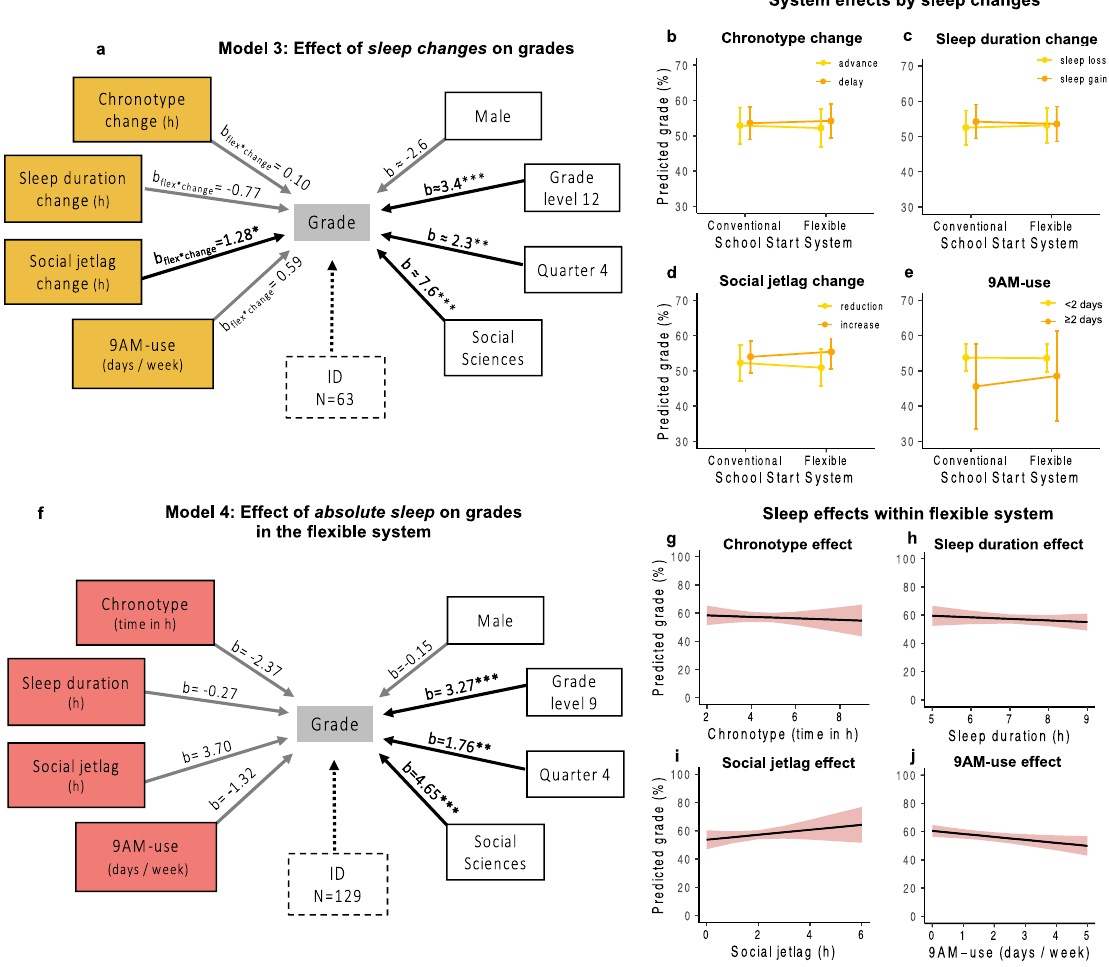
Figure 3. Longitudinal analysis of official quarterly grades—effects of sleep and 9 AM-use. Results from linear mixed model analyses of quarterly grades (0–100%) considering sleep variables and the frequency of ≥ 9 AM-starts (see Table 2 for sample descriptions). ( a,f) Schematic of the structure and results from Models 3 and 4 (Supplementary Tables S3 and S4) showing the outcome, official quarterly grades (center), all predictors (black-framed boxes), the statistical significance of their effect (arrows; black: p < 0.05, grey: p ≥ 0.05), the unstandardized regression coefficients (b-values) and ID as random intercept (dashed box). General predictors (white) are categorical variables, so the levels with the highest impact are shown compared to their reference (female, grade level 10, quarter 1, languages). b-values are approximate in ( a), indicated by ≈, as representing results from Models 3a–d. ( a) Effect of changes in sleep and of 9 AM-use on grade improvements from the conventional to the flexible system. Summarized results from Models 3a–d (n ID = 63; Supplementary Table S3) where each model variation included a different yellow predictor in interaction with school start system (conventional/flexible; b flex*change ) to model effects of sleep changes on grade changes. ( b–e) Visualization of the yellow interaction effects from ( a ) via marginal means, i.e. grade estimates and 95% CI for the reference (female student, class level 10, quarter 1, languages) and categorical splits in the continuous sleep change variables to facilitate display. The effect of school start system on grades by ( b) chronotype change (advance/delay), ( c) sleep duration change (sleep loss/sleep gain), ( d) social jetlag change (reduction/increase) from the conventional to the flexible system, and by ( e) the frequency of 9 AM-use (< 2 days/ ≥ 2 days) in the flexible system. ( f) Effect of absolute sleep characteristics on grades in the flexible system. Summarized results from Model 4e (n ID = 129; Supplementary Table S4) predicting grades only for the flexible system, i.e., 1.5 years post-change, including the red sleep predictors in one common model after running separate Models (4a–d) to check for collinearity. ( g–j) Visualization of the red effects from ( f ) via marginal means, i.e. grade estimates and 95% CI for the reference (female student, class level 10, quarter 1, languages). * p < 0.05; ** p < 0.01; *** p <